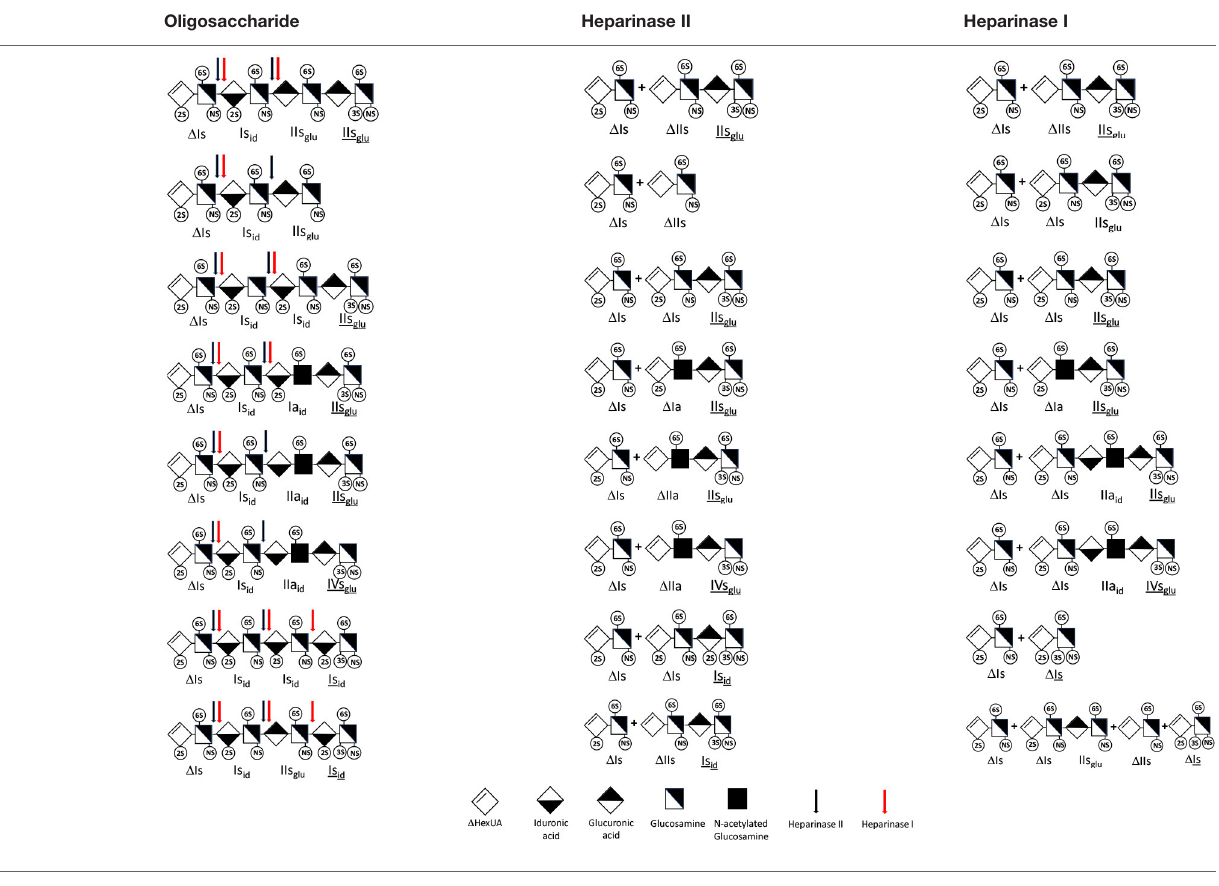
TABLE 2 | Comparison of heparinase II and heparinase I digestions of key